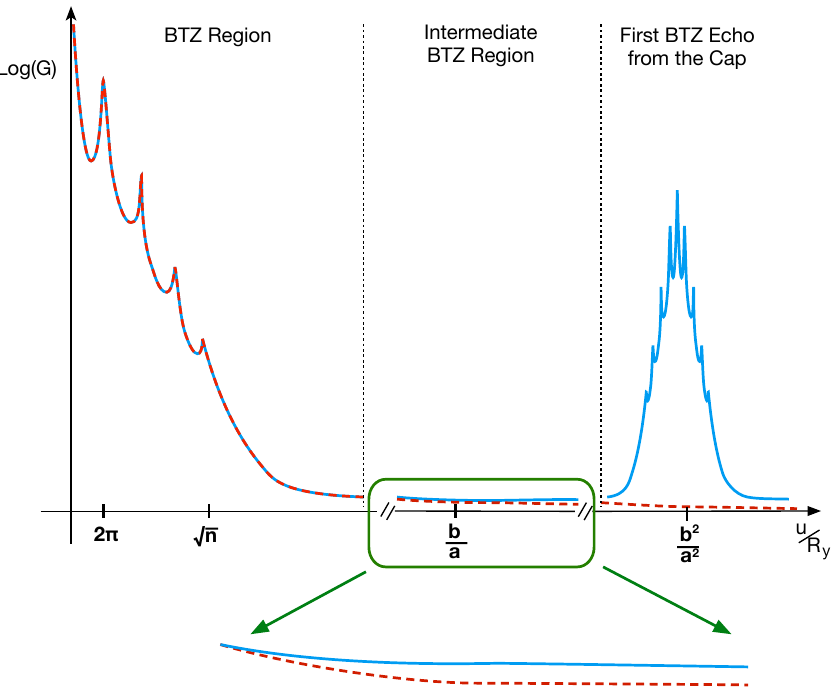
Figure 13: Schematic description of the ( 1,0, n ) -superstratum Green function in po- sition space (continuous line in blue) and its comparison to the extremal BTZ Green function (dashed line in red). At early times of order R lar to that in Figure 11, with polynomial fall off briefly interrupted by singularities at every ∆ u = 2 π R from the light-cone wrapping around the y -direction. (The y singularities are cut off in the picture to clarify their relative weight.) At times of or- / a ∼ (cid:112) N N R der b R , the behavior of the superstratum two-point function starts y y 1 5 to deviate from that of extremal BTZ, following (6.22). Finally, at times of order / a 2 ∼ N b 2 R N R , the superstratum Green function features its first significant y y 1 5 echo which is absent in BTZ. It is a slightly-attenuated and deformed copy of the singularity around u ≈ 0. Ever less significant echos will follow at times equal to / a 2 integer multiples of b 2 R y